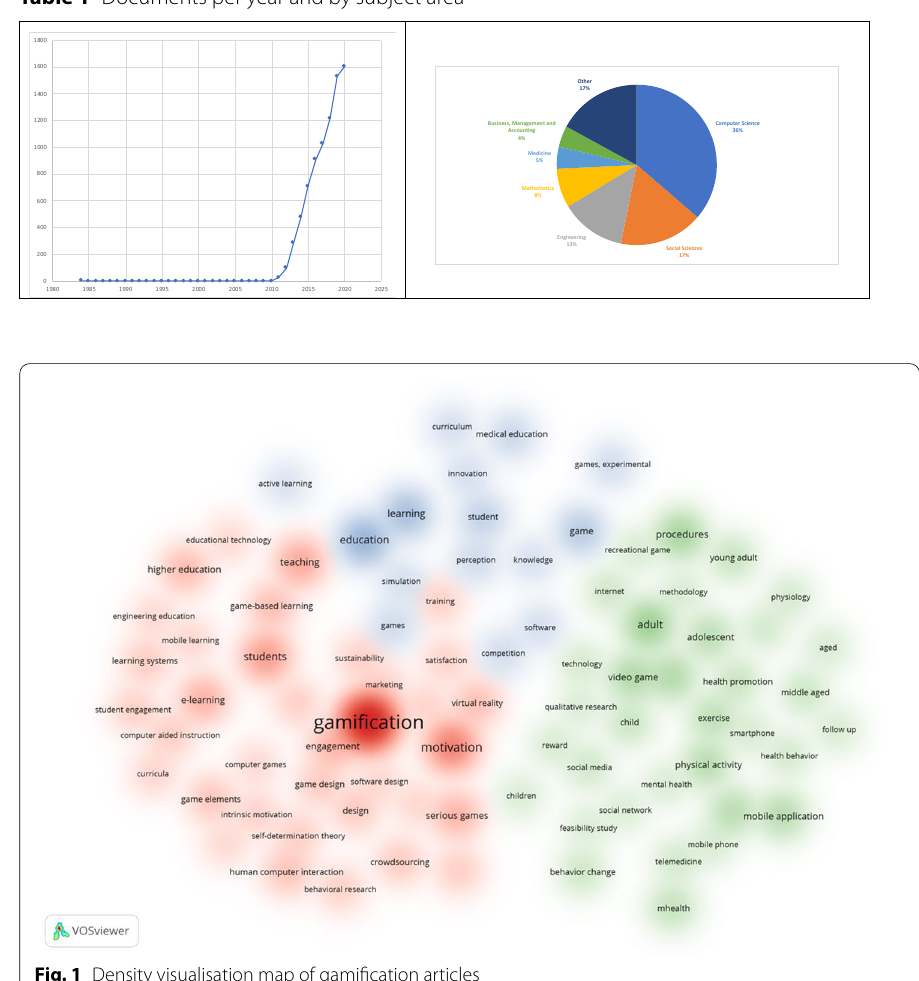
Table 1 Documents per year and by subject area